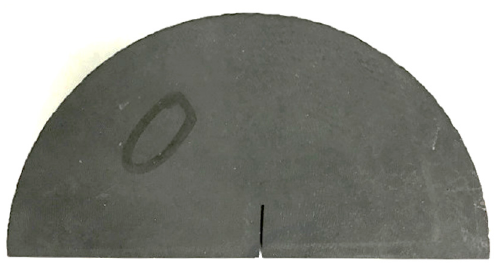
Figure 1. Notched semi-circular bend (NSCB) sample. Table 1. Geometric parameters of notched semi-circular bend (NSCB) samples.